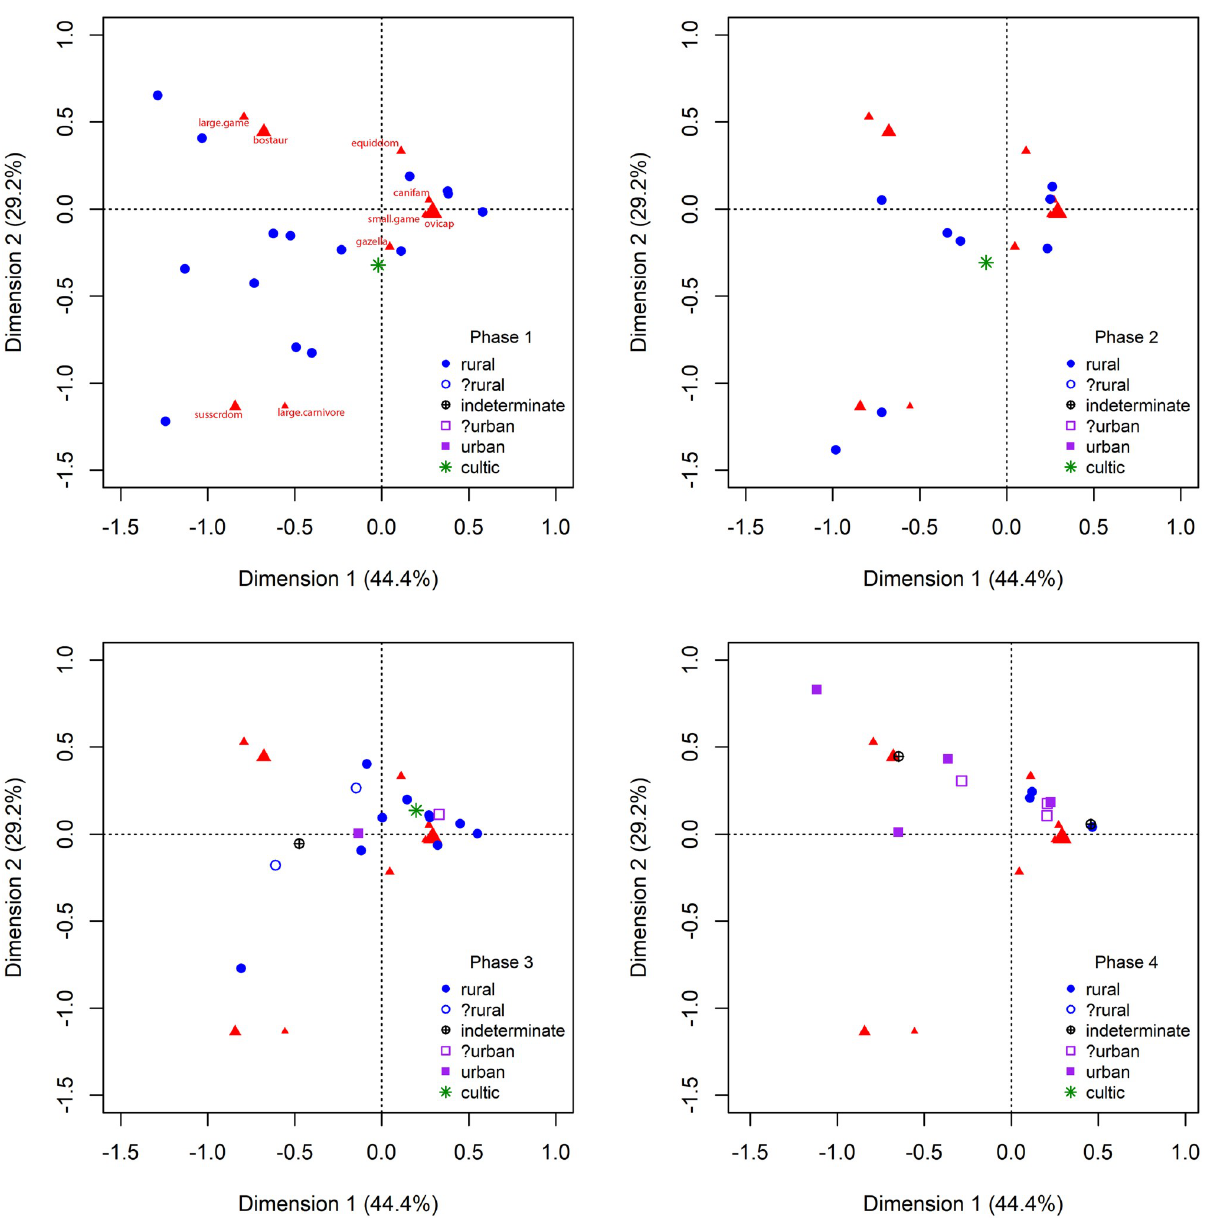
Fig 2. Correspondence analyses of taxonomic distributions for Phases 1 through